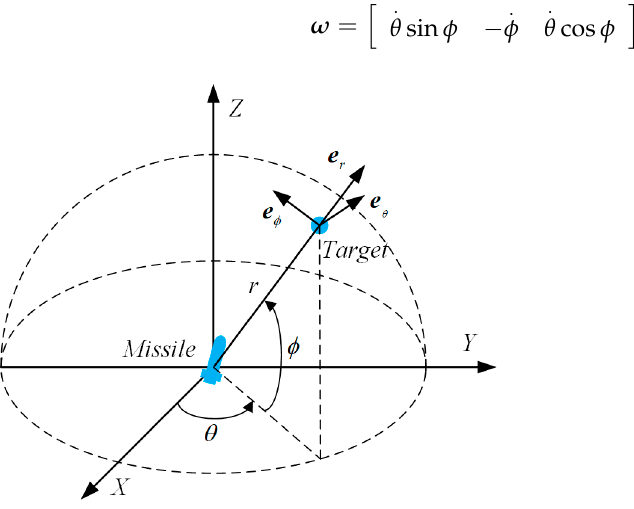
Figure 1. Three-dimension schematic diagram of missile-target